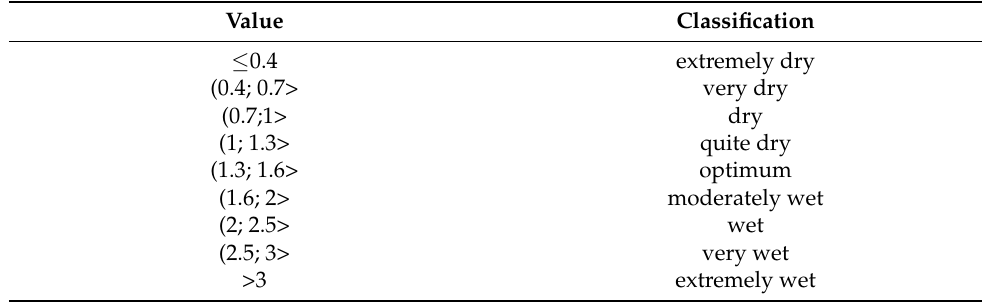
Table 2. Classification of the values of Sielianinov’s